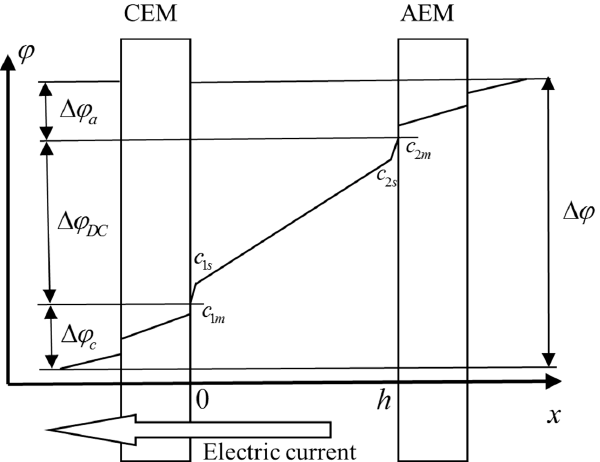
Figure 11. Schematic distribution of the electric potential. The variations within quasi-equilibrium interfacial EDLs are shown as vertical lines. c 2 s and c 1 s relate to the positions of counterion minimum concentration near the AEM and the CEM, respectively; c 1 m and c 2 m show the position of the points where the counterion concentration profile passes from the solution to the membrane phase.